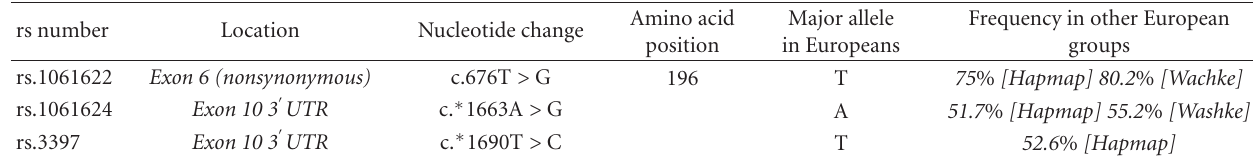
Table 1: TNFRSF1B polymorphisms tested in the Canterbury